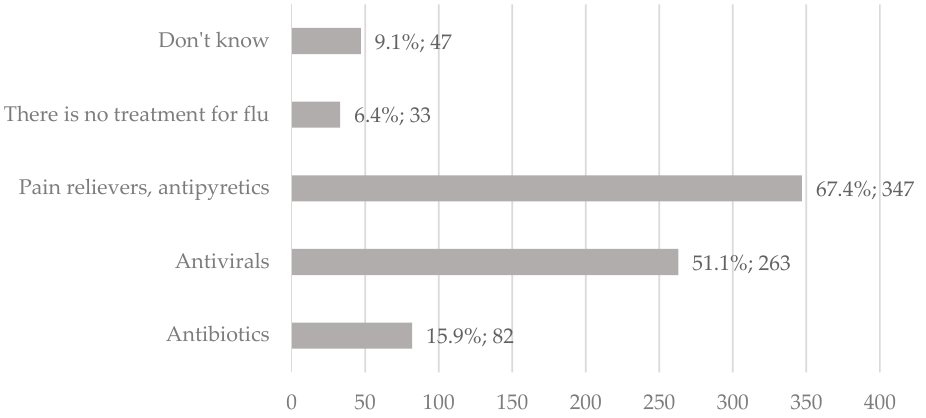
Figure 2. Respondents’ knowledge about influenza treatment.